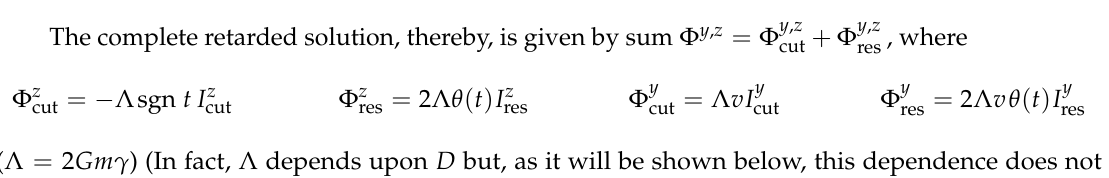
Figure 1. Integration contours in the complex ω